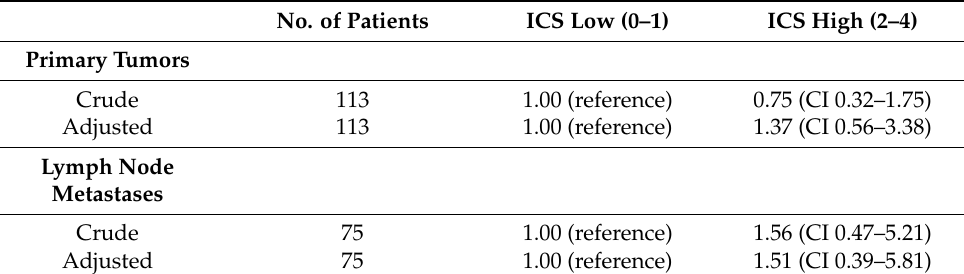
Table 3. Hazard ratios (HRs) for disease-specific mortality with 95% confidence intervals (CIs) in primary small bowel neuroendocrine tumors and lymph node metastases in low and high immune cell score groups.